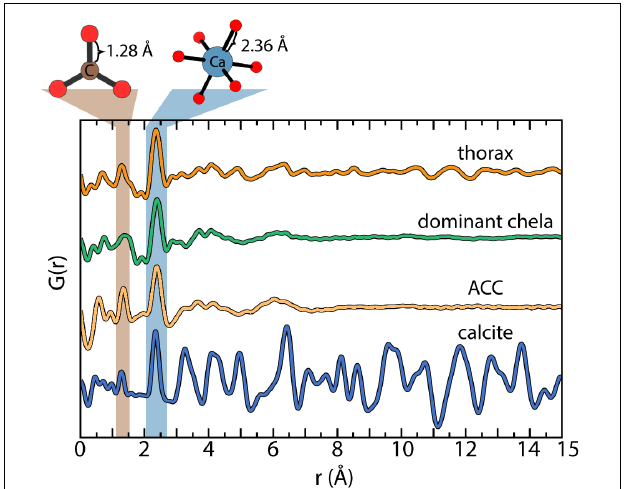
FIGURE 2 | Characteristic pair distribution function (PDF) analysis determined for the reference standards (Michel et al., 2008) and the bulk fraction of the thorax and dominant chela. The similar profiles of amorphous calcium carbonate (ACC) and the dominant chela indicate the predominance of ACC. Linear analysis of the PDF data estimate the mineral component of the thorax and dominant claw is ≈ 85 and ≈ 97% ACC, respectively, with the remainder as